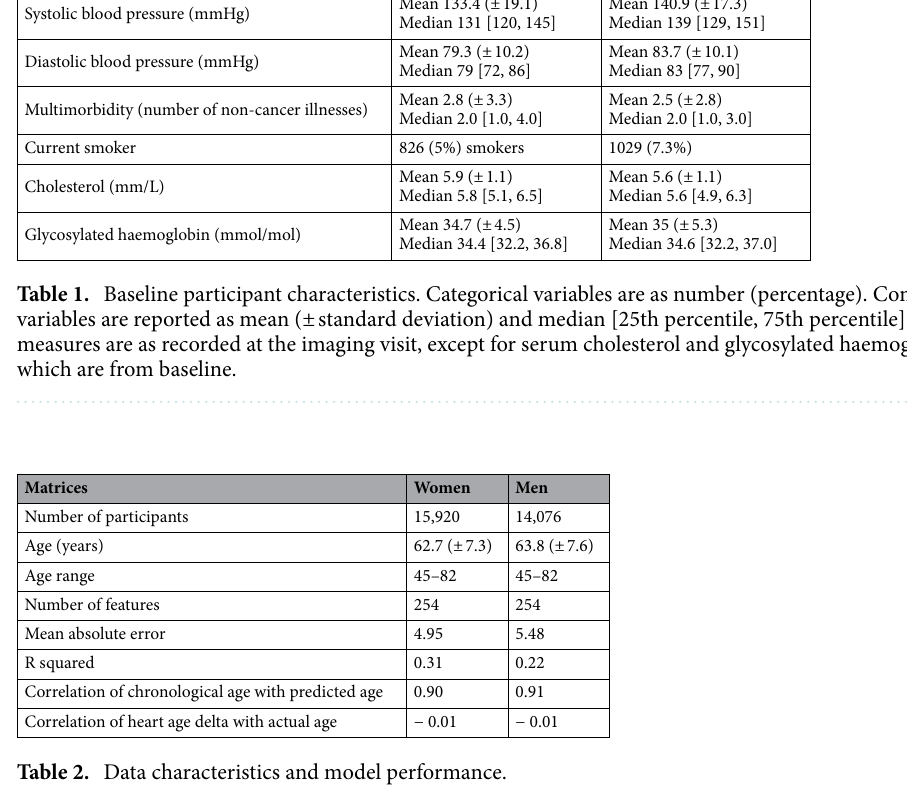
Table 2. Data characteristics and model